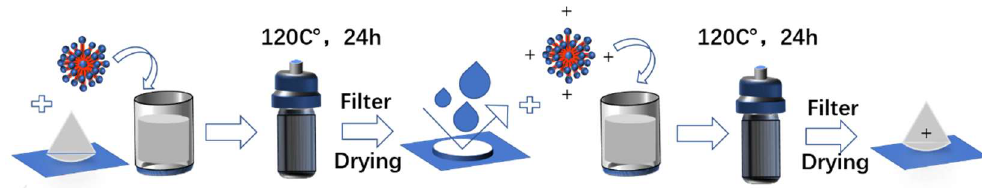
Figure 1. Main process steps for preparing antistatic, oil-cleaning, shell-based materials.